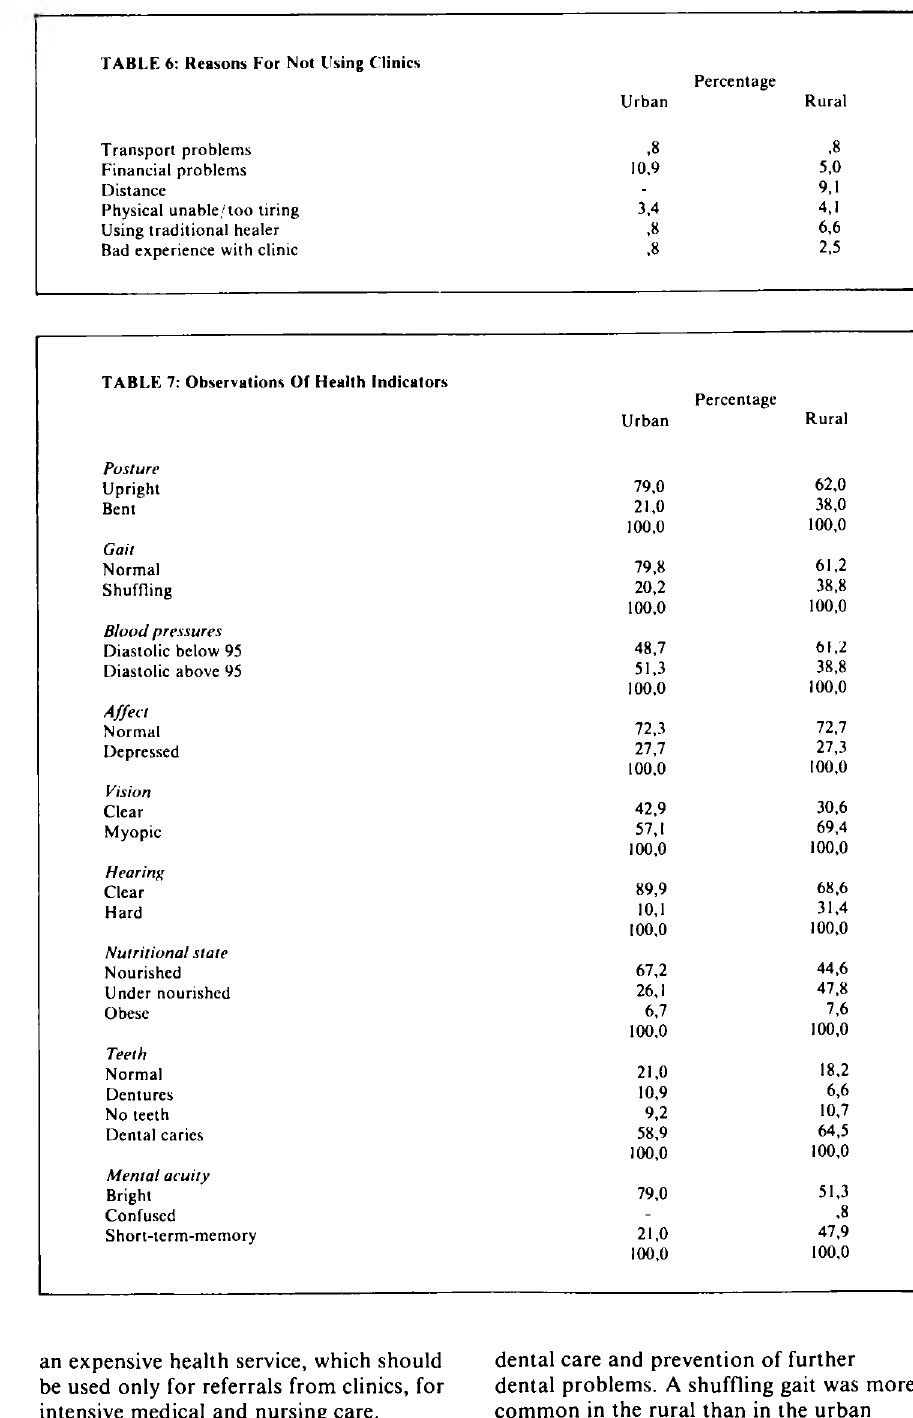
TABLE 6: Reasons For Not Using Clinics